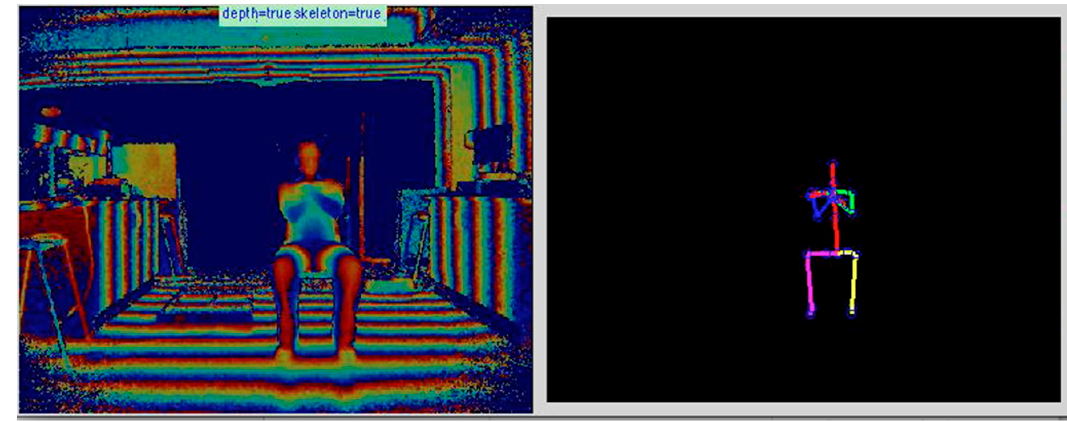
Figure 1. Example output of the Microsoft Kinect One depth sensor and skeleton model renders in MathWorks Matlab (2016B).